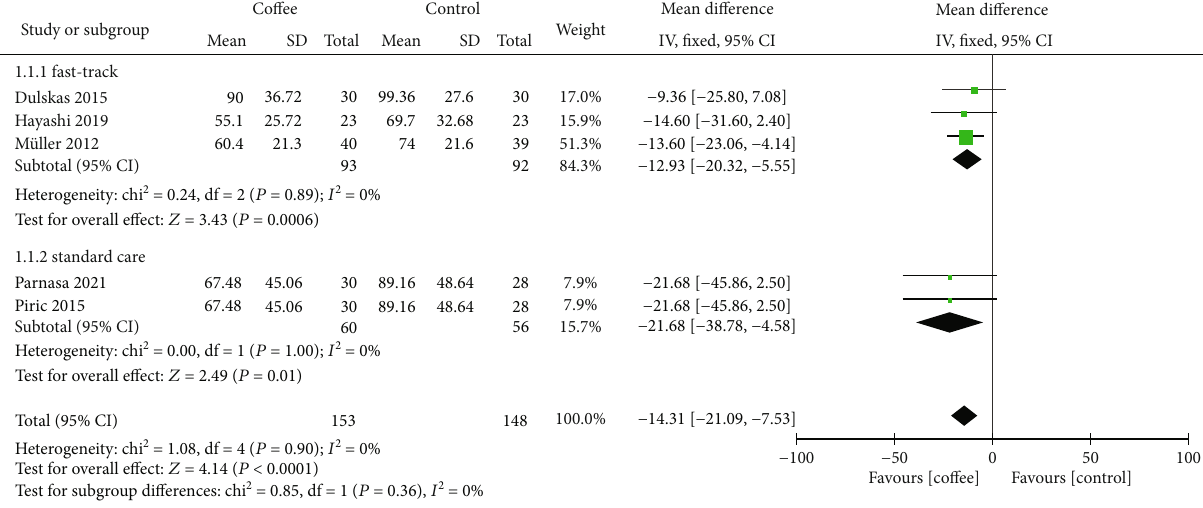
Figure 5: Subgroup analysis of the time to fi rst defecation by type of perioperative management